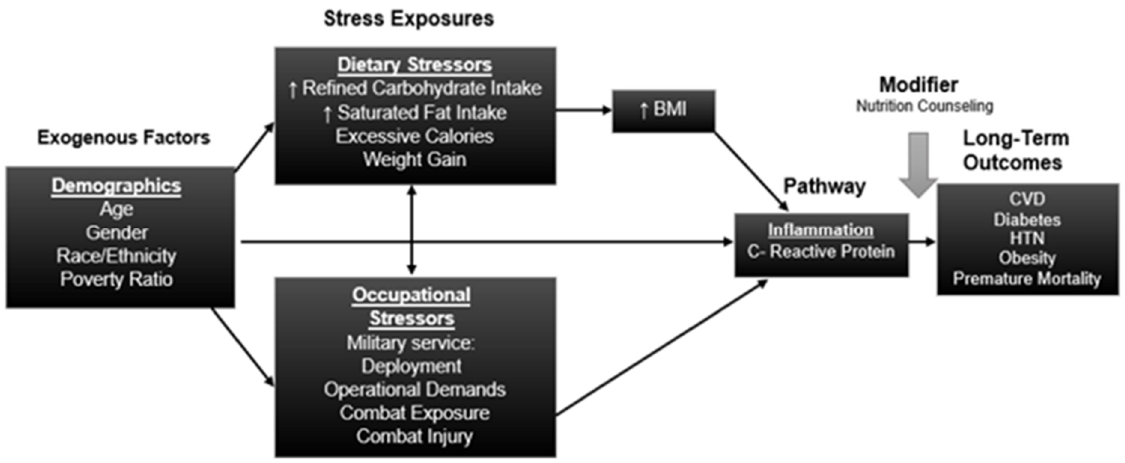
Figure 2. Conceptual model of stress exposures, pathway, and long-term outcomes. BMI indicates body mass index, CVD indicates cardiovascular disease, HTN indicates hypertension.